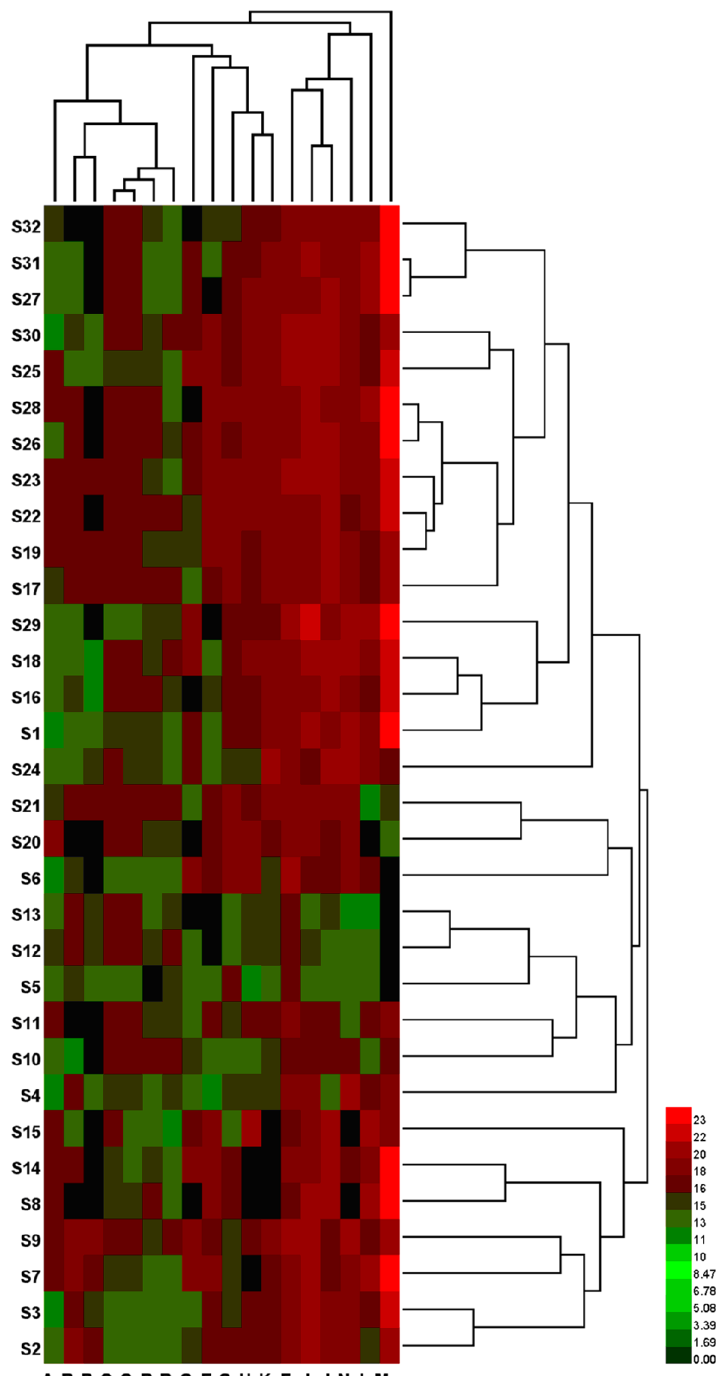
Figure 2. Hierarchical clustering analysis of S . miltiorrhizae samples. Samples S1–S32 are performed using HemI statistics software (Heatmap Illustrator, Version 1.0). The between-groups linkage method as the amalgamation rule and the squared Euclidean distance were selected to establish